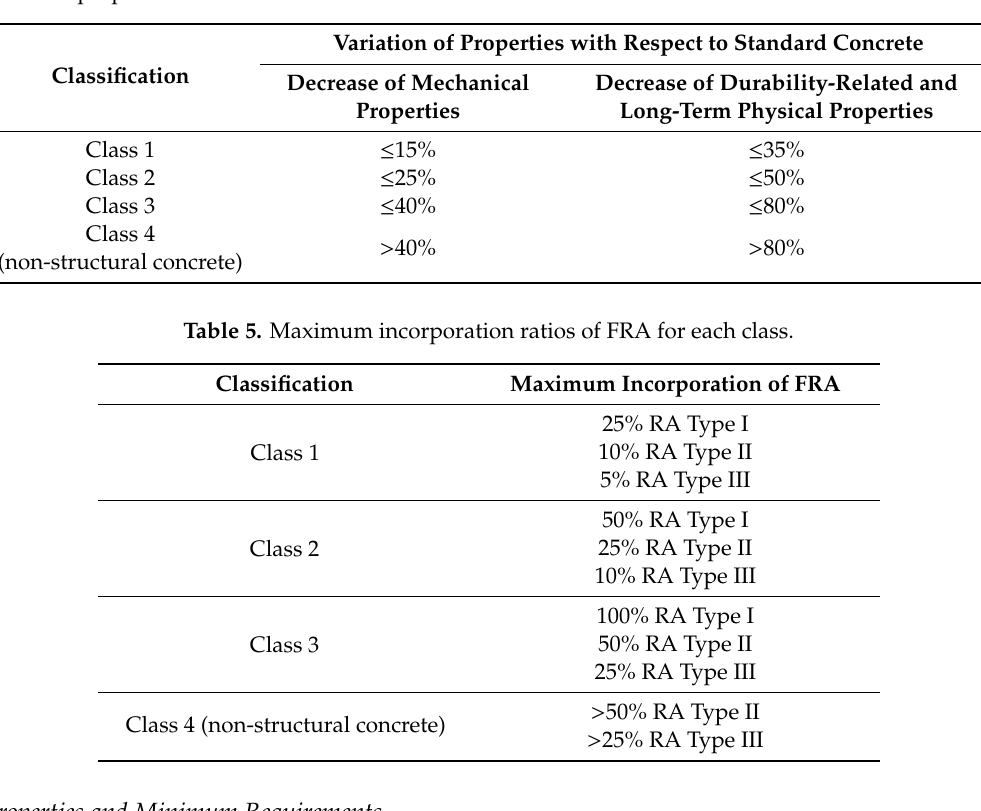
Table 4. Classification of FRA as a function of the consequences of their incorporation in concrete properties.